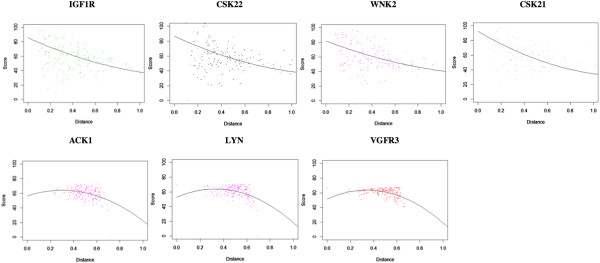
Two different types of outlier trends, which are likely to explain the formation of 2 clusters of outliers. VEGFR3, ACK1 and LYN show consistently high SAR similarity with other kinases at both low and high distances, with lower SAR similarity against some kinases at high distances (see graphs below). CSK21, CSK22, IGF1R and WNK2 show significantly higher SAR similarity with other kinases at low distances than at higher distances, but with very high variance of the data points: in many cases, neighboring kinases show low SAR similarity or distant kinases show high SAR similarity (see graphs above). Regardless, 2 different types of outlier trends were observed, possibly explaining the grouping of the outliers in 2 different clusters in the MDS plot.